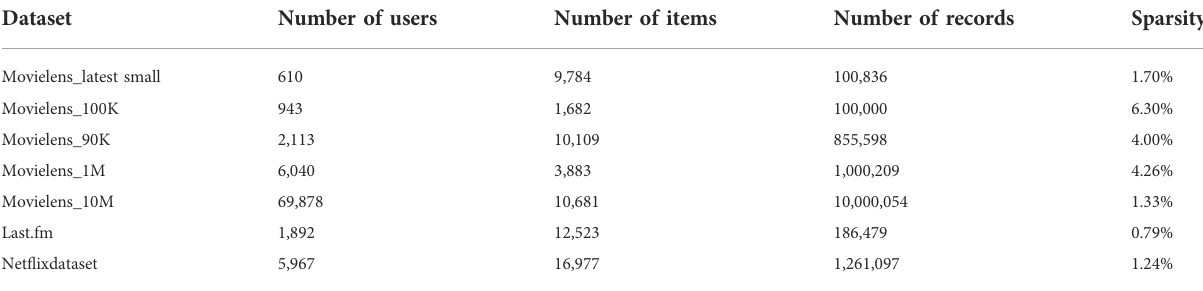
TABLE 1 Introduction of